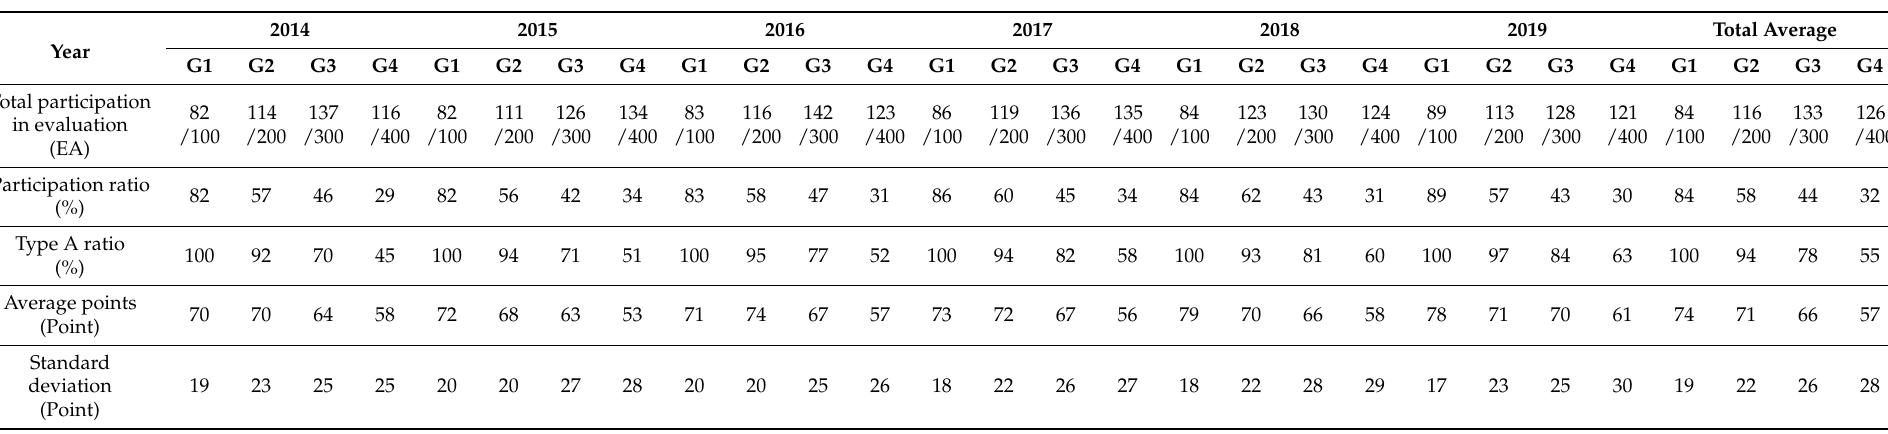
Table 6. Average points of evaluation performance by group classified according to